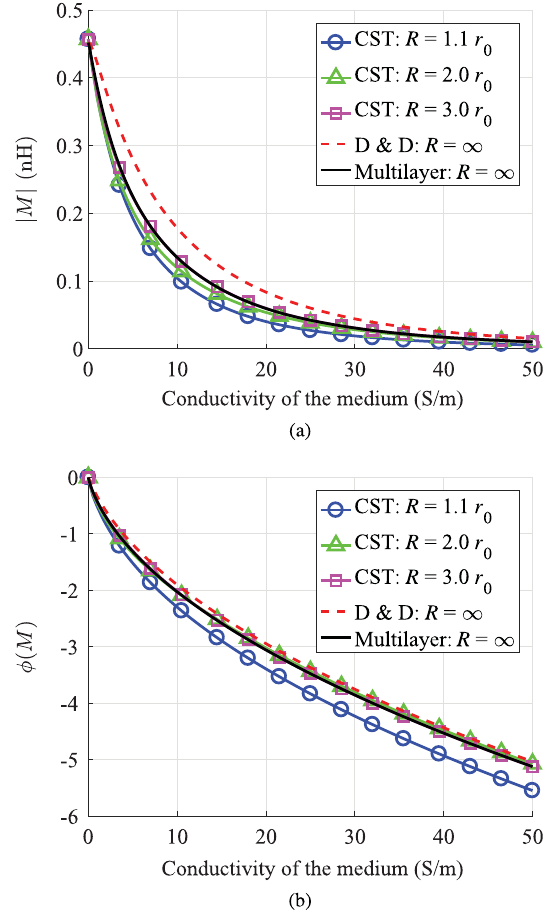
Fig. 3. Mutual inductance ( M ) of two coaxial circular coils of radius r 0 =11 mm and spaced apart d = 37mm inside a conductive medium with conductivity variable from s =0 to s =50 S/m. (a) Modulus and (b) phase of M obtained by the multilayer solution are compared with D&D solutions [21] and CST MWS simulation results for three different sizes of the insulating boxes.